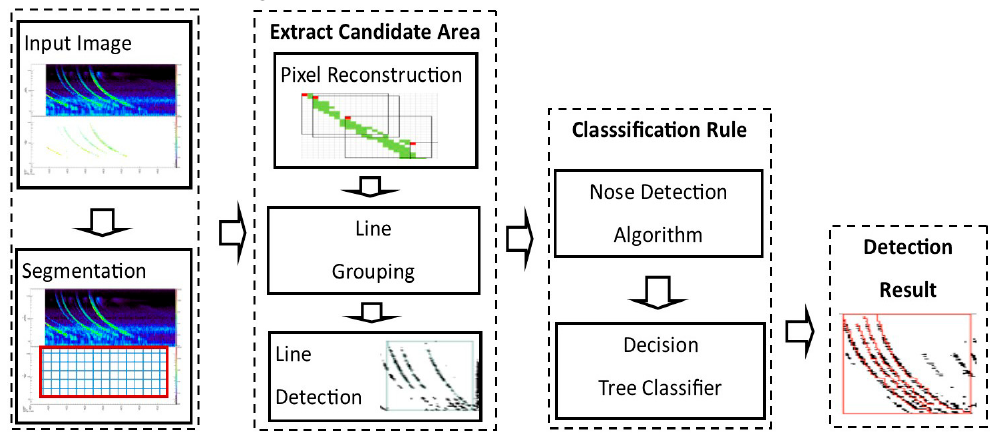
Figure 5. The overall flow chart of the whistler detection system. The process from left to right shows segmentation, extraction of the candidate area, the classification rule, and the detection result.